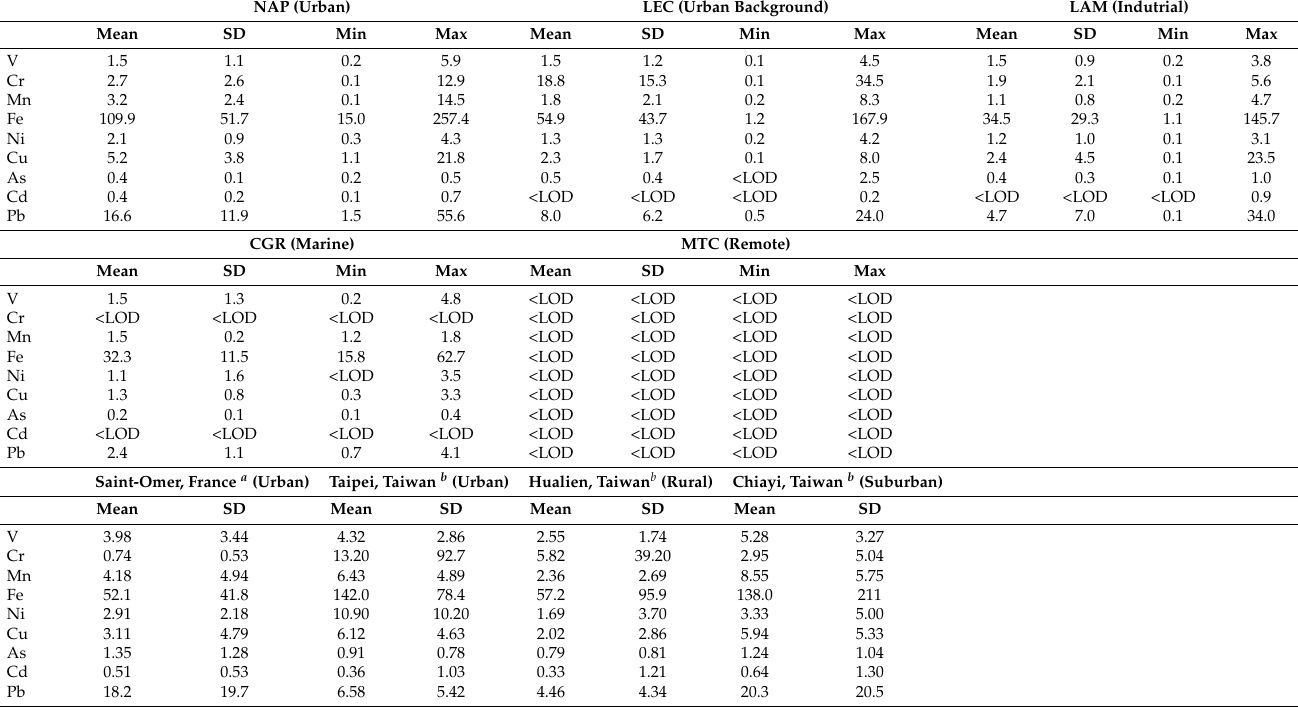
Table 5. The mean, minimum, maximum and standard deviations (SD) of the element concentrations in PM 2.5 : the concentrations are in ng/m 3 ; LOD, limit of detection; NAP, Naples; LEC, Lecce; LAM, Lamezia Terme; CGR, Capo Granitola; MTC, Monte Curcio. a [77]; b